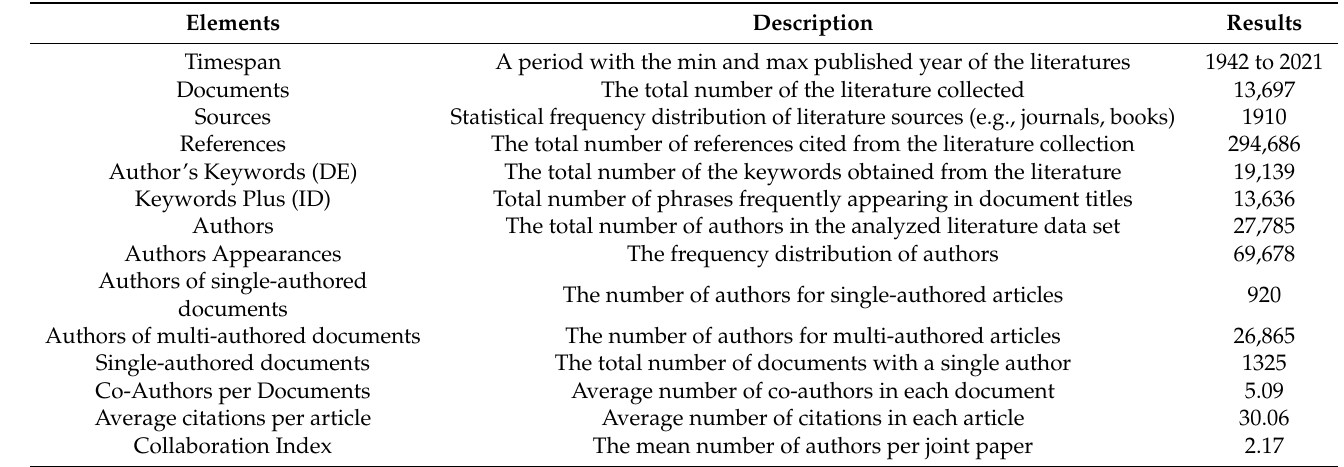
Table 2. Main information about the collected literature obtained from the bibliometric